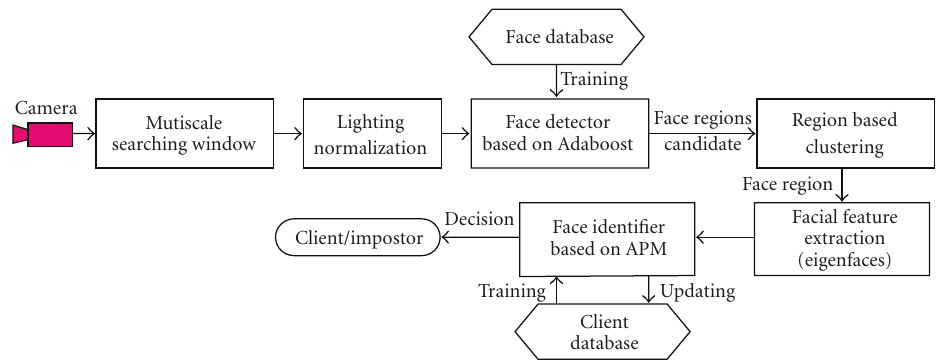
Figure 1: Architecture of the proposed face recognition